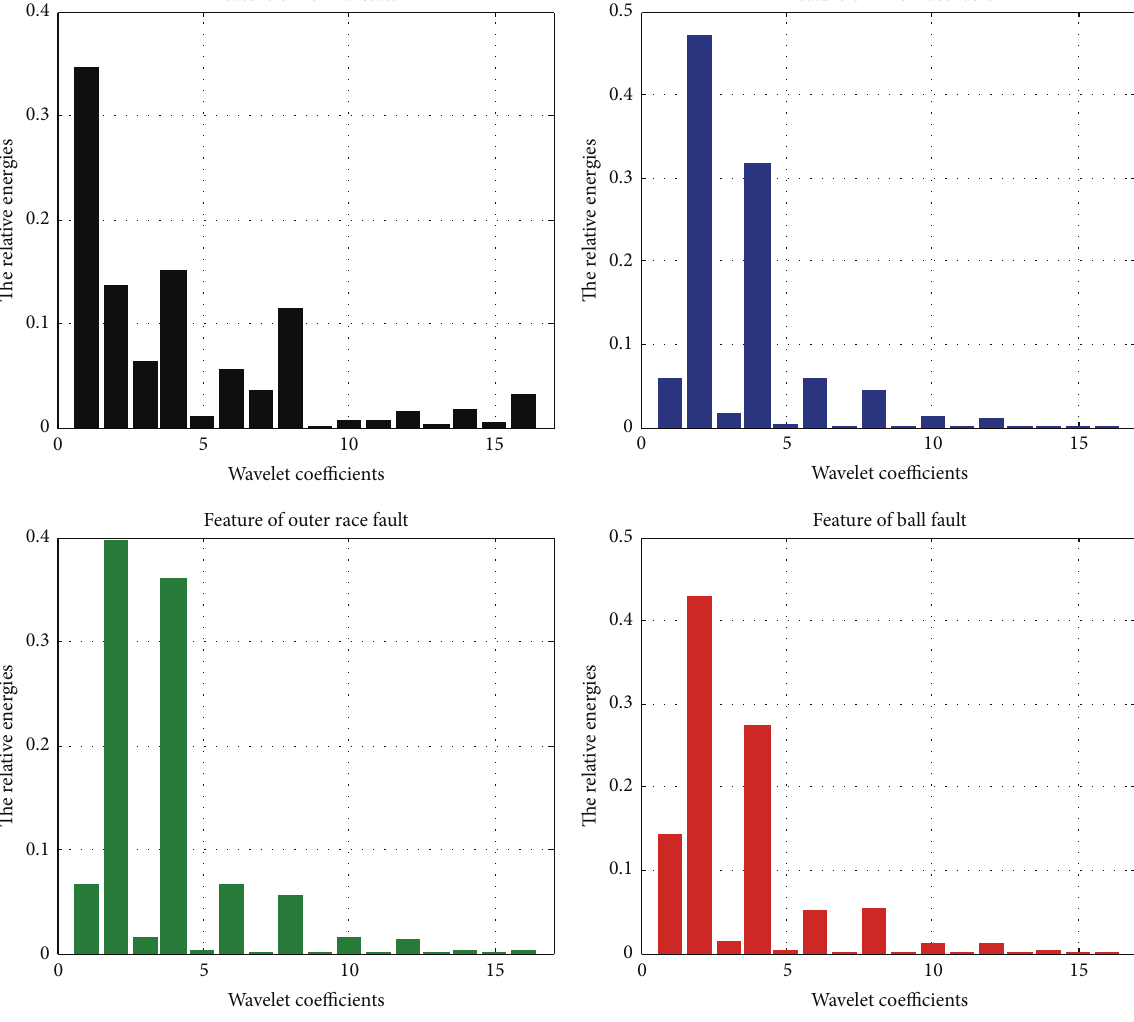
Figure 3: The features of a group of samples with different